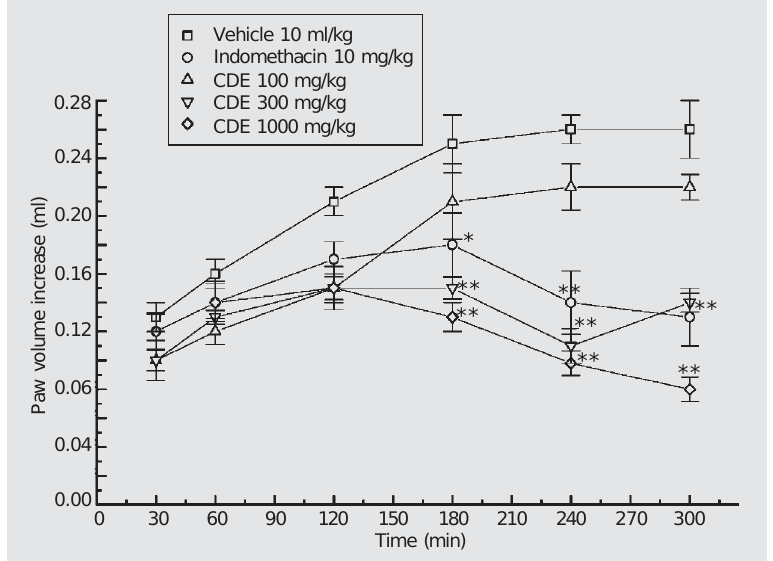
Figure 1. Effect of the crude dichloromethane extract (CDE) of Cordia curassavica ( po ) on carrageenin-induced paw edema in mice. Data are reported as means ± SEM for 6 mice in